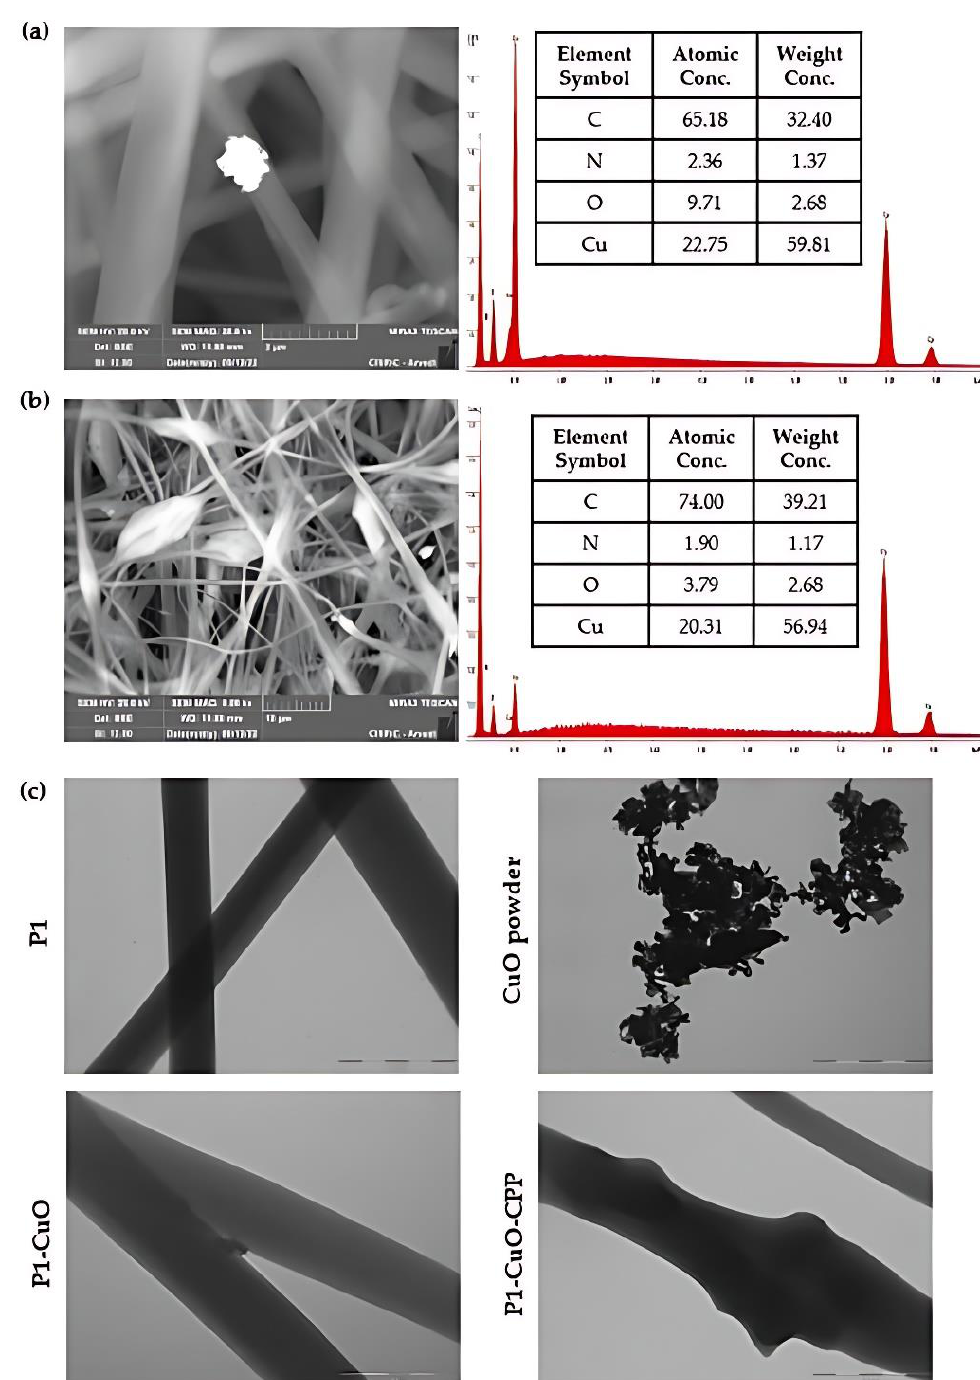
Figure 3. SEM-EDX of ( a ) P1-CuO and ( b ) P1-CuO-CPP scaffolds. ( c ) TEM micrographs of the scaffolds with and without CuO and of the CuO powder (scale bar: 1 µm). The interfacial properties and wettability of the scaffolds, both in the aligned and random structures, were evaluated using contact angle measurements. The scaffold mor- phology and dimensions do not change after